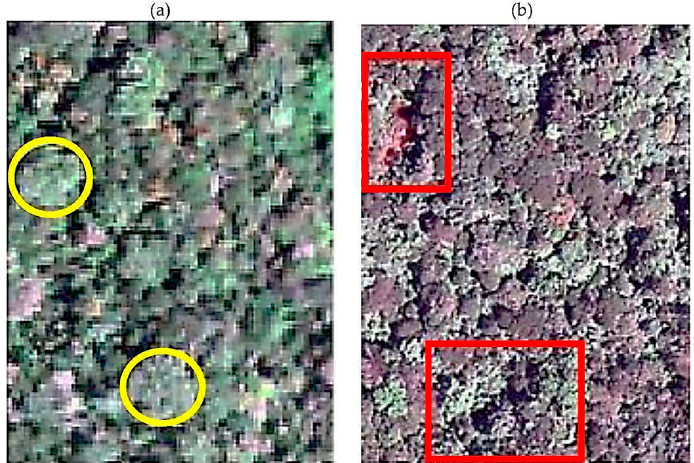
Figure 2. A true-colour image showing ( a ) two uncut Ocotea trees in the 2014 WorldView-2 image; ( b ) canopy gaps created after cu tt ing the camphor trees in the 2019 WorldView-3 image. ( b ) canopy gaps created after cutting the camphor trees in the 2019 WorldView-3